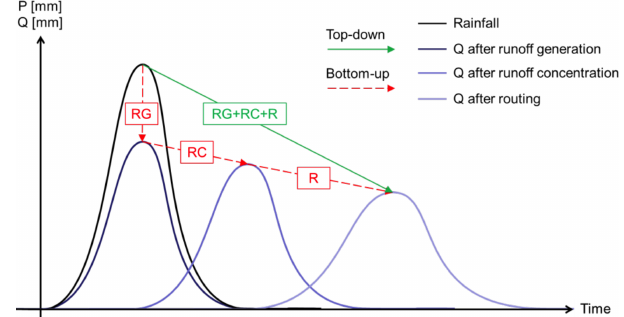
Figure 5. Representation of runoff generation (RG), runoff concen- tration (RC) and routing (R) in the bottom-up (red), and in the top- down (green) set-ups. Adapted from Krebs et al.